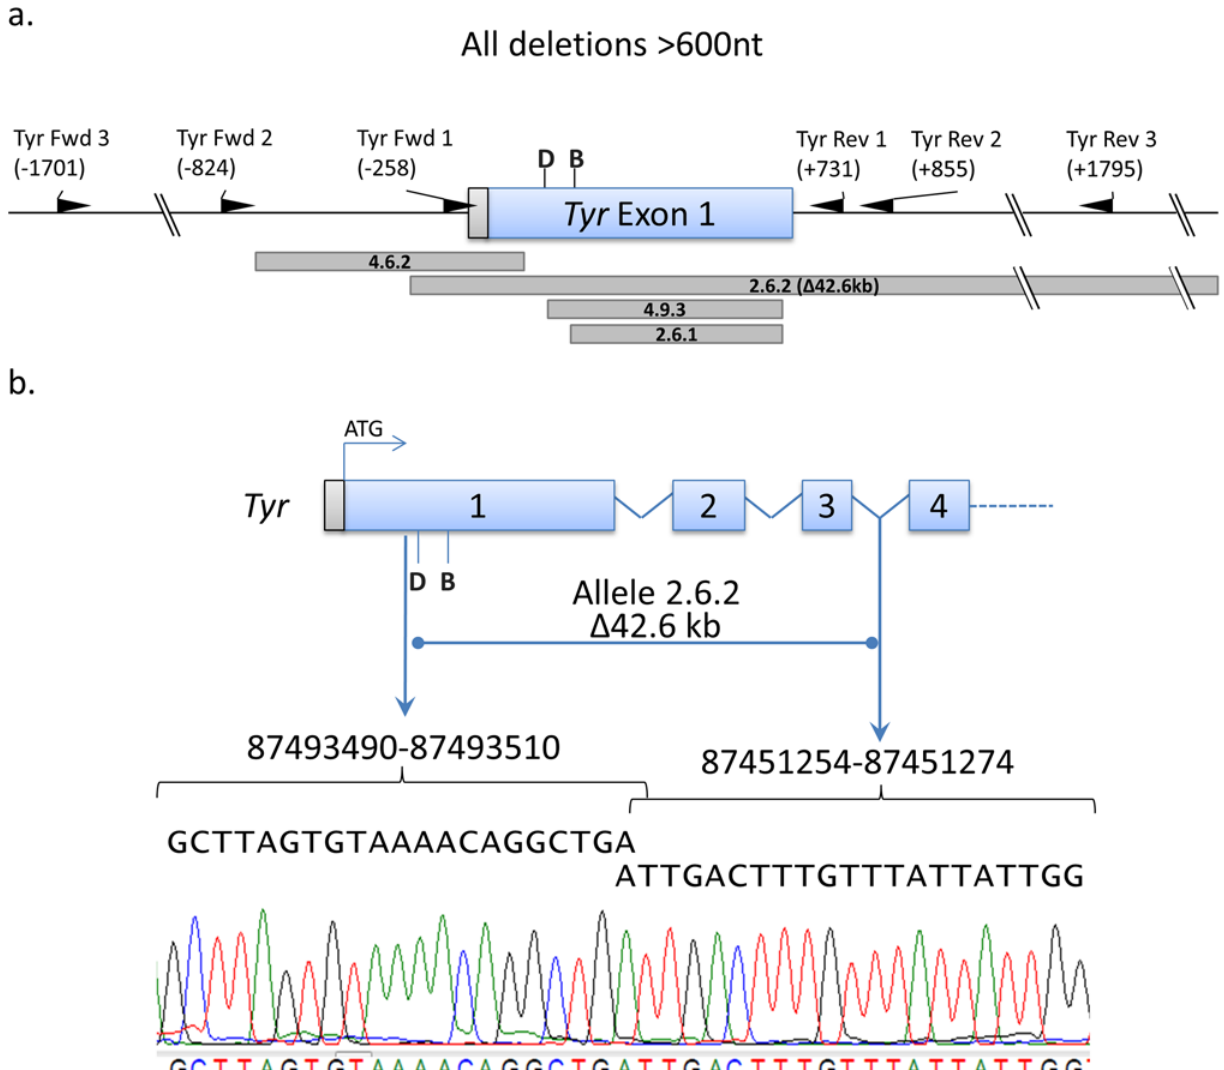
Figure 8. Large deletions occur with CRISPR-Cas9-mediated genome editing. (a) Three sets of PCR primers (Table 4) were used to identify large deletions ( > 600 nt) across the targeted region. The position of the 5 0 end of the primer relative to predicted Cas9 cleavage site for the closest sgRNA is shown in parenthesis. The hash marks indicate regions that are not depicted in this panel. Guide B and D target sites are labeled (B) and (D), respectively. The positions of deleted nt are shown with respect the alleles in which they were identified below the schematic of the gene. (b) The identity of the large 42.6kb deletion from allele 2.6.2 is depicted as the sequence tracing of PCR product of the fused gene demonstrates the NHEJ repair junction. The numbering is based on the GRCm38.p2 reference assembly (mm10) for Mus musculus